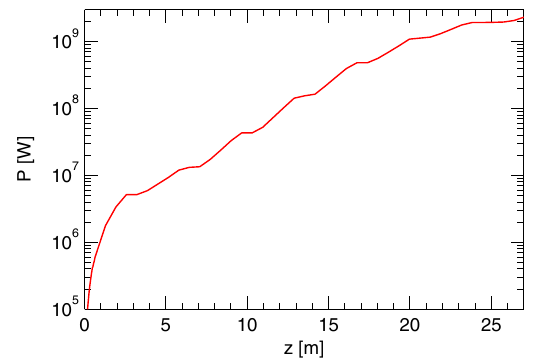
FIG. 15. Variation of peak radiation power at the fundamental with distance through the radiator for time-dependent simula- tions of NLS FEL-3 operating at 1 keV photon